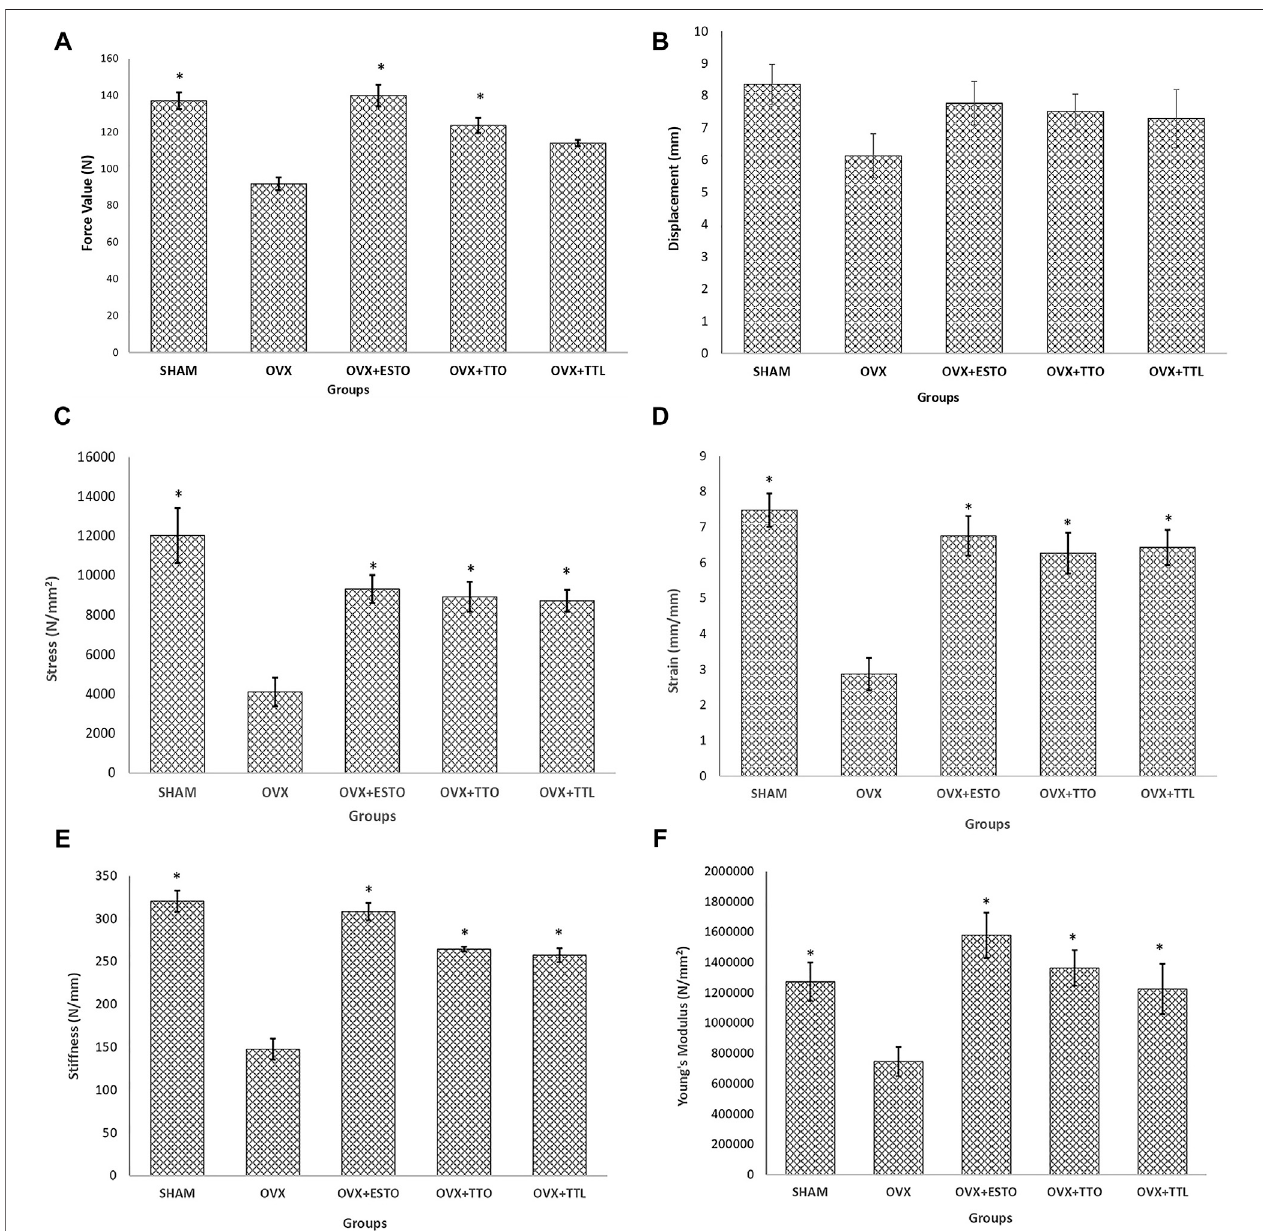
FIGURE 6 | Biomechanical parameters. (A) Maximum force before failure of the tibial bone. (B) Maximum displacement before failure of the tibial bone. (C) Maximumstressbeforefailureofthetibialbone. (D) Maximumstrainbeforefailureofthetibialbone. (E) Stiffnessofthetibialbone. (F) Young ’ smodulusofthetibialbone. SHAM, sham-operated group; OVX, ovariectomized control group; OVX + ESTO, ovariectomized + oral estrogen; OVX + TTO, ovariectomized + daily oral tocotrienol; OVX+TTL,ovariectomized+IOinjectionoftocotrienol+PLGA.*Signi fi cantdifference( p < 0.05)whencomparedwiththeovariectomizedcontrolgroup(OVX).The data are expressed as mean +